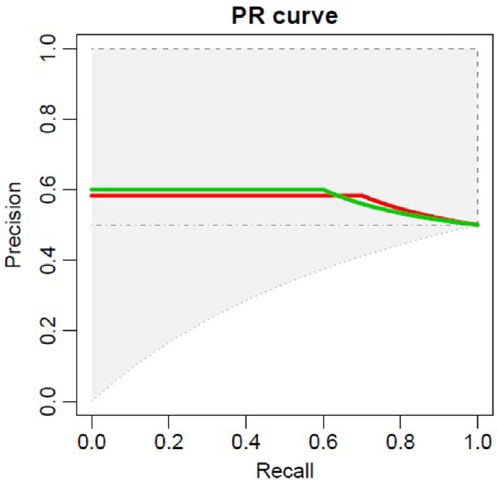
Fig. 9. The PR curves before applying the gene selection method for sample size of